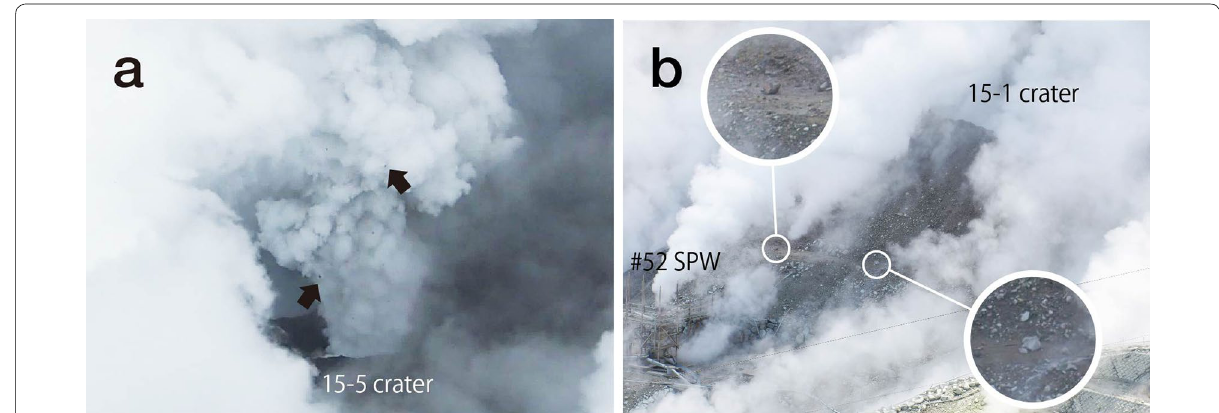
Fig. 14 a Ballistic clasts flying from the 15-5 crater. Arrows show examples of ballistic clasts. Diameter of the 15-5 crater was estimated to be 7 m (11:03 of June 30). b “Ballistic clasts” on a trail near the 15-1 crater (10:52 of July 10). All photographs were taken by HSRI from location c in Fig. 2